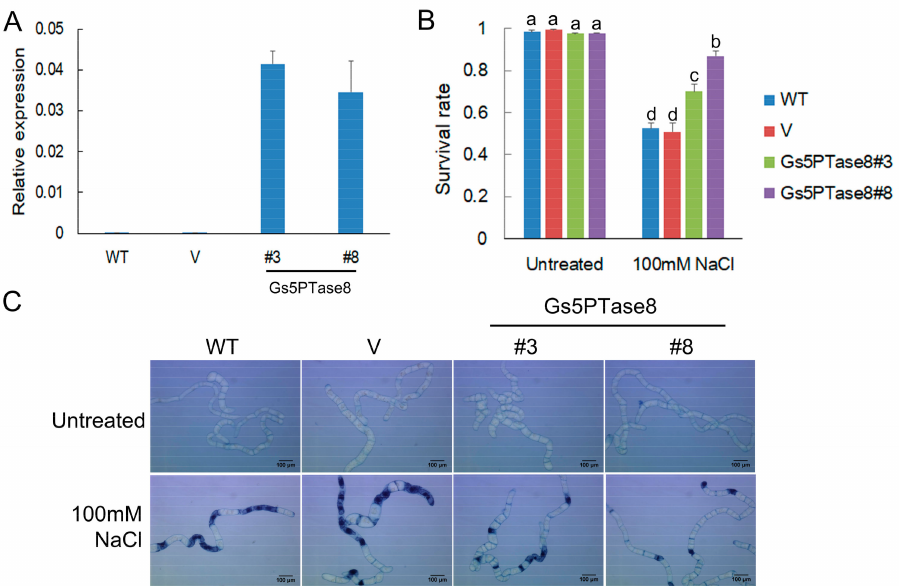
Figure 2. Cell viability assay of BY-2 cells under salt treatment. Four-day-old BY-2 cells cultured in MS medium were used, including the wild type (WT), the vector-only control line (V), two independent Gs5PTase8 transgenic lines (Gs5PTase8#3 and Gs5PTase8#8). The cells were treated or untreated with 100 mM NaCl for 20 h and the dead cells were visualized by trypan blue staining. ( A ) The expression of transgenes (2 − ∆ Ct ) were validated by qRT-PCR. The data were normalized to the tobacco reference gene L25 . ( B ) The quantitative analysis of survival rates. For each sample, around 200~300 cells were counted randomly. Three replicates of each experiment were performed. Values are mean ± SE. The data were analyzed using ANOVA followed by the Duncan’s post hoc test ( p < 0.05). The significant di ff erences were indicated by di ff erent letters above the bars. ( C ) The images of the BY-2 cells by trypan blue staining. Scale bars indicate 100 µ